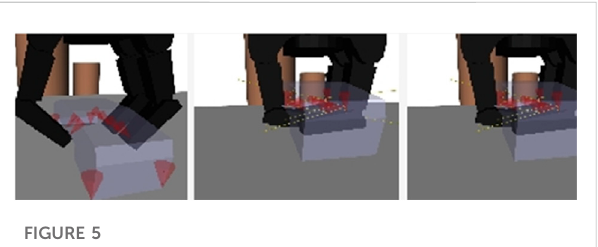
FIGURE 5 GraspIt simulator for pose prediction (Miller and Allen, 2004).